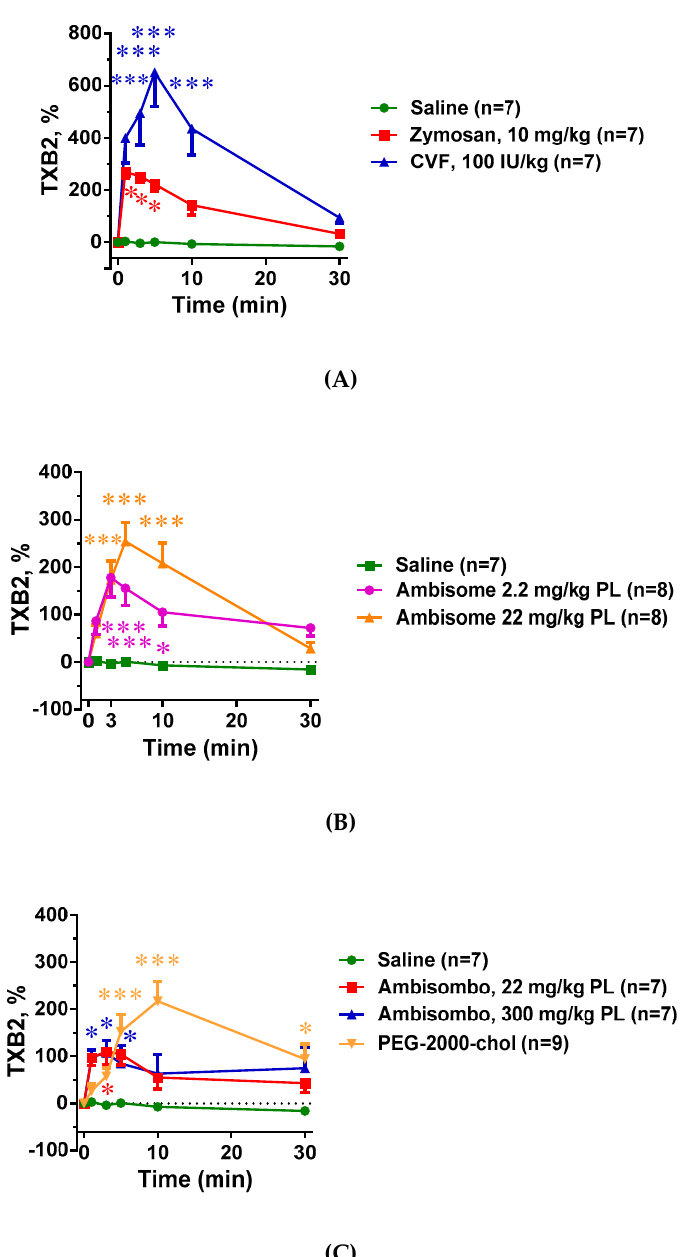
Figure 5. Effects of direct complement activators ( A ), amphotericin B-containing ( B ), and empty liposomes ( C ) on plasma white blood cell (WBC) counts in anesthetized rats. The doses and number of animals are specified in the keys. The data show % change relative to baseline (t = 0 min), mean ±